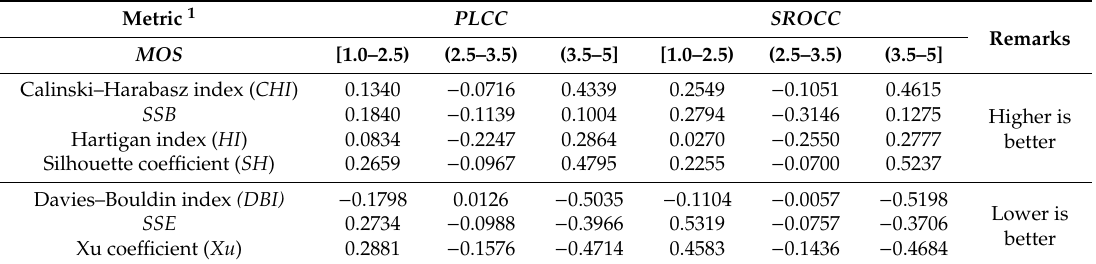
Figure 6. Comparison of SROCC and PLCC values (obtained from Tables 7–9) for: ( a ) internal validation scores ( DBI , Xu , SSE ), ( b ) external validation scores, ( c ) FR-IQA measures, and ( d ) internal validation scores ( HI , SSB , CHI , SH ). Red y = x line denotes where SROCC and PLCC values are equal. Table 10. Correlation between di ff erent quality groups of MOS scores and internal validation